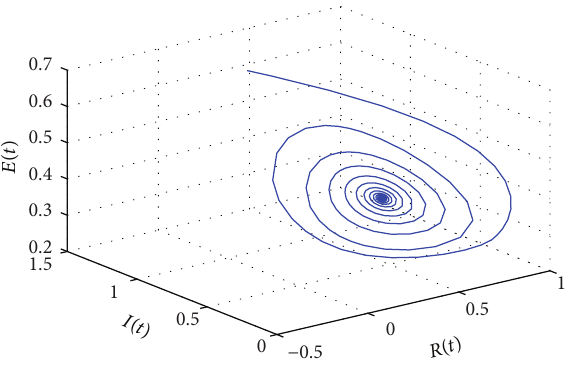
Figure 2: The phase plot of the states 𝐸 , 𝐼 , and 𝑅 for 𝜏 = 8.0025 < 8.9829 = 𝜏 0 .